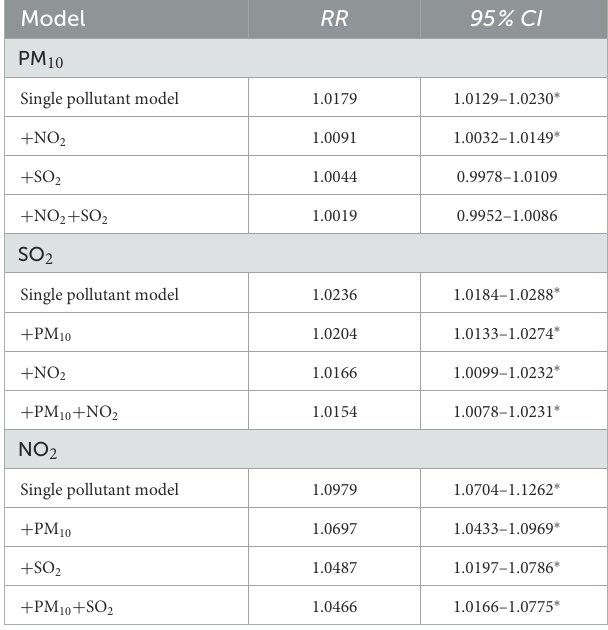
TABLE 4 Results of hospital admissions for appendicitis after adjusting for other